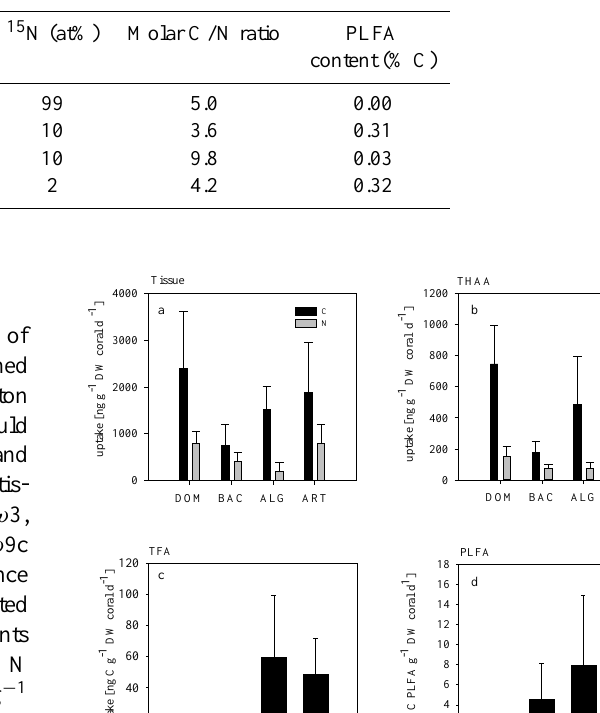
Table 1. Characteristics of food sources used during the experiment.